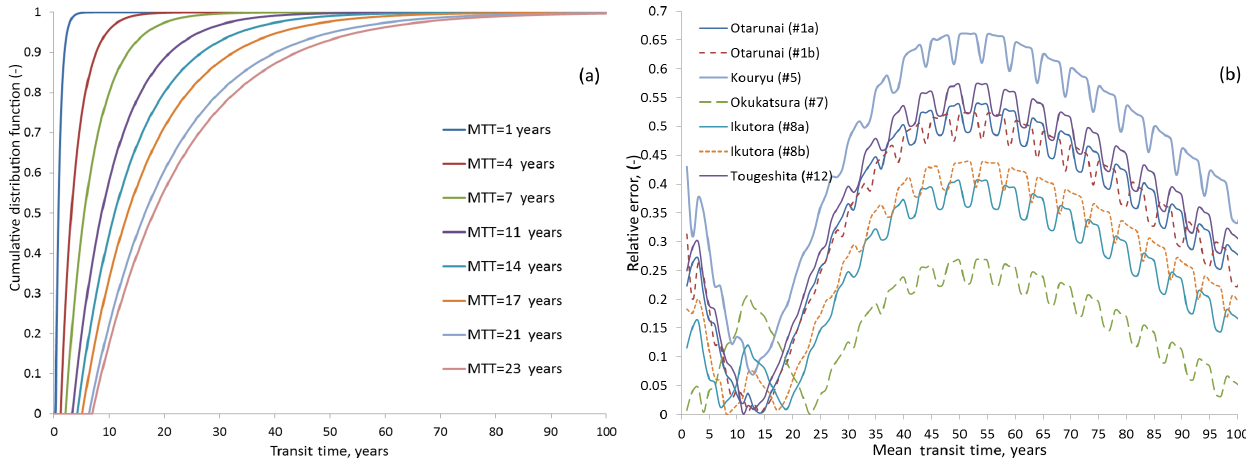
Figure 7. Transit time distributions of the exponential (70%) piston flow (30%) model (E70%PM) for obtained MTT solutions (a) and relative error between simulated and analysed tritium at selected locations for MTTs between 1 and 100 years (b) . Table 3. MTTs estimated using E70%PM described in the text. One, two, or three possible MTTs are obtained using relative error (RE) between analysed and simulated